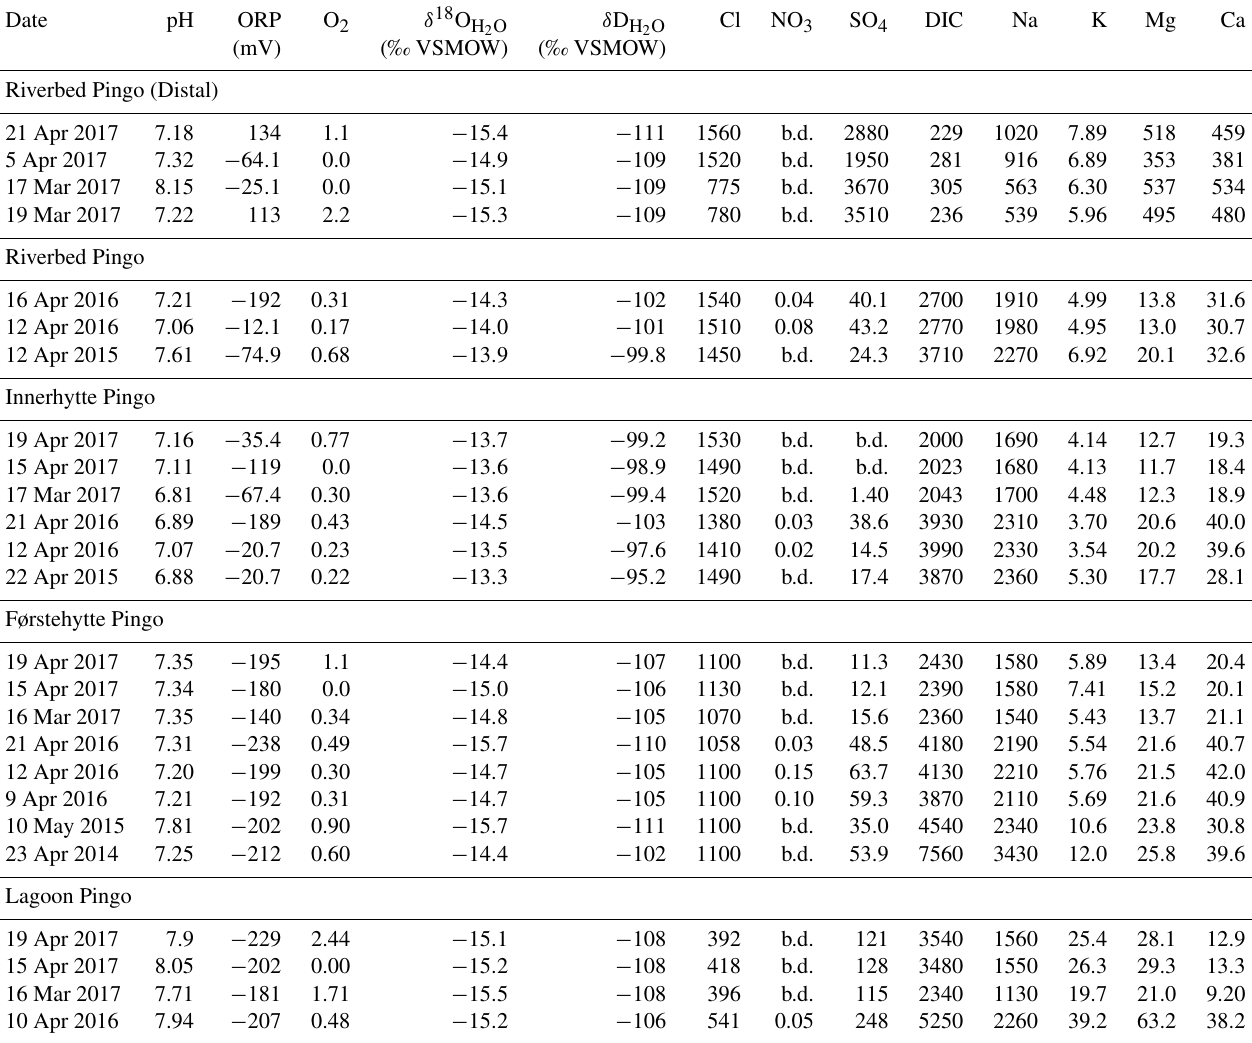
Table 1. Geochemical characteristics of Adventdalen pingo springs during pre-melt season sampling. All units are in milligrams per litre (mgL − 1 ) unless otherwise stated. NO 3 is reported as milligrams of nitrogen per litre (mgNL − 1 ), and “b.d.” means below detection (ca. 0.02mgL − 1